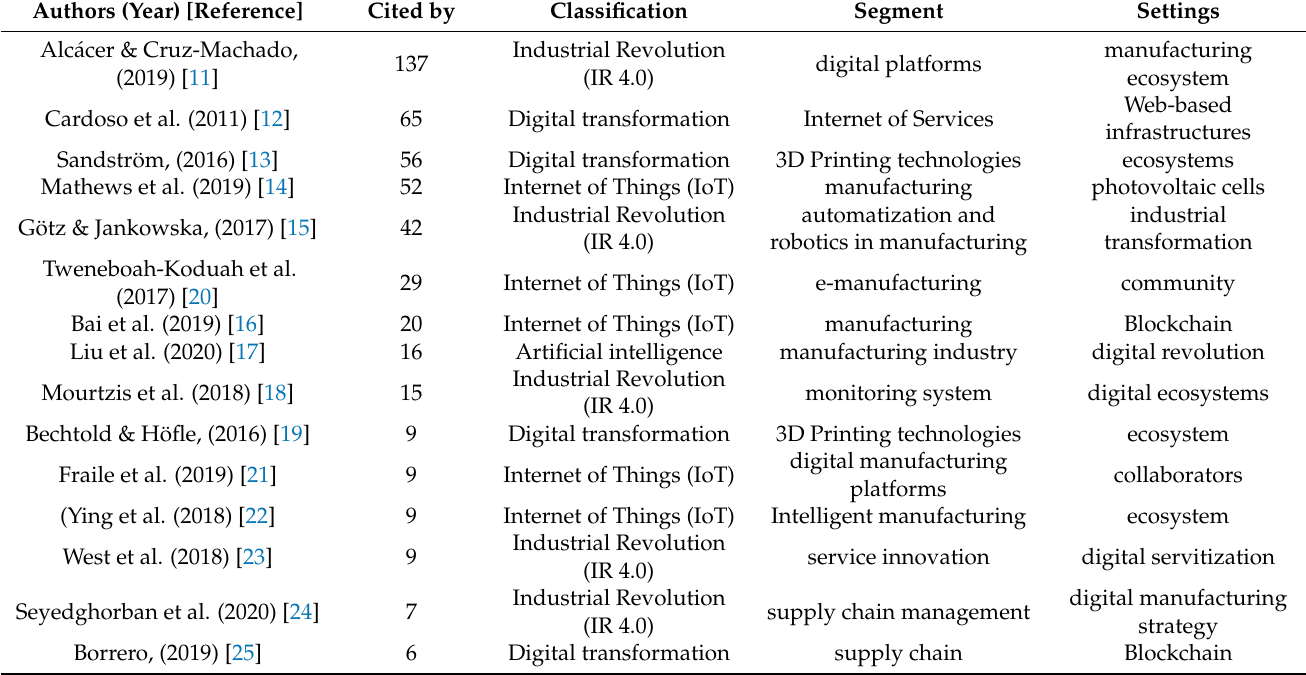
Table 2. Distribution of author, citations, and classifications from